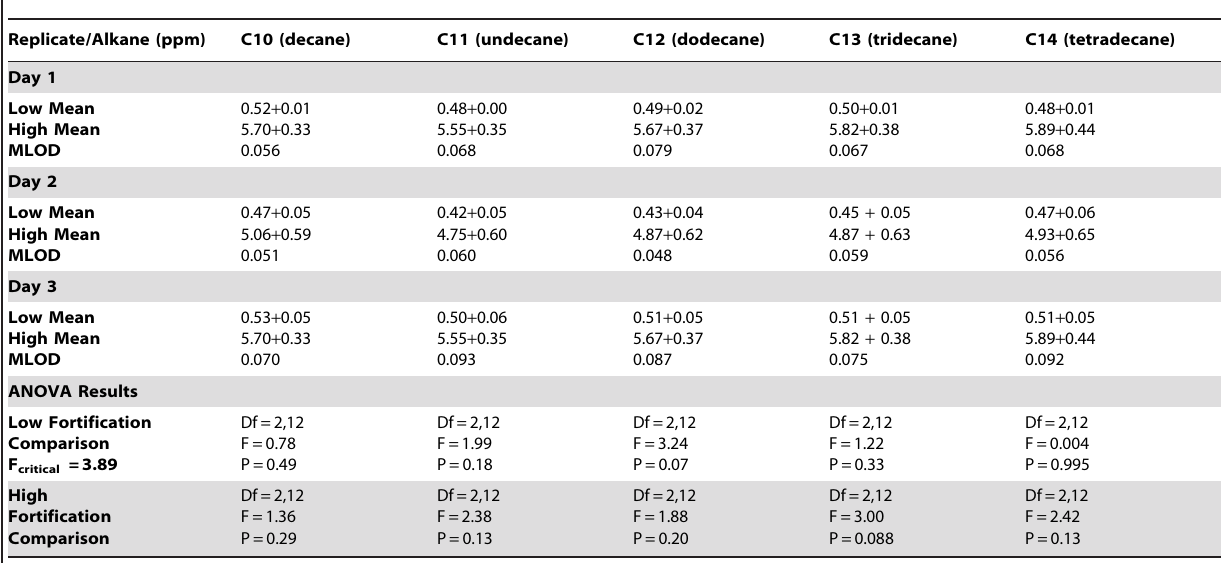
Table 1. Solvent extraction method development mean alkane concentrations observed across replicates.